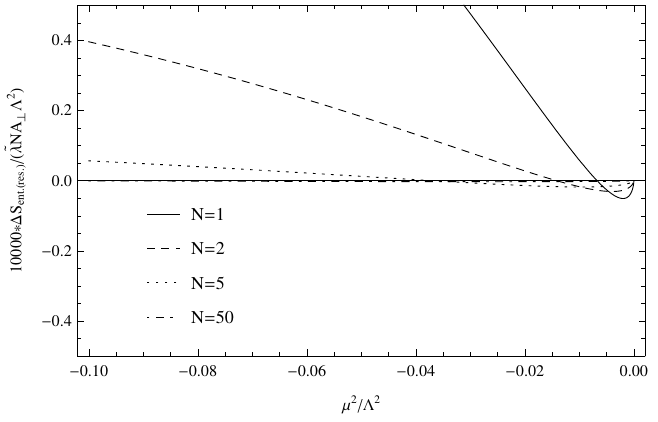
Figure 5 . λ -dependent subleading part of the entanglement entropy at O ( λ ) in the symmetry broken phase. Note that this plot is ˜ λ -independent, as it is in units of N ˜ λA ⊥ Λ 2 , magnified by a factor of